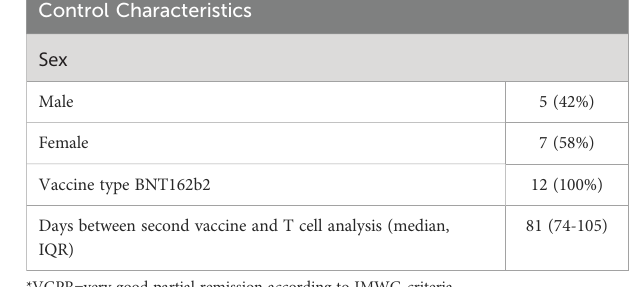
Peptides and CD3/CD28 from the same control are shown in Supplementary Figure S1. Furthermore, in S-Peptides-stimulated